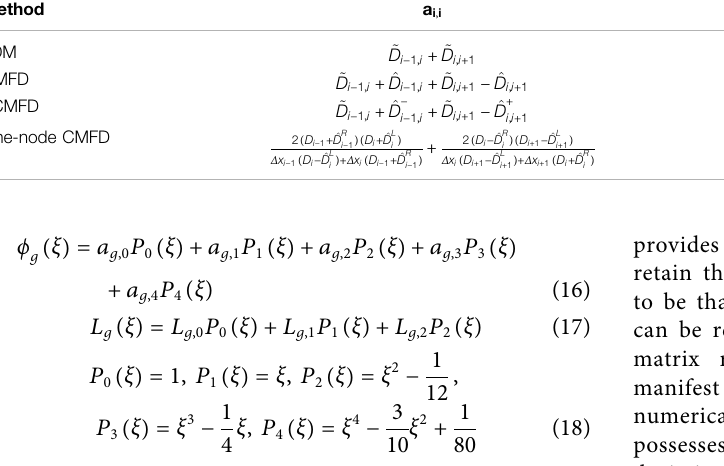
TABLE 1 | Migration matrix entries for CMFD methods.